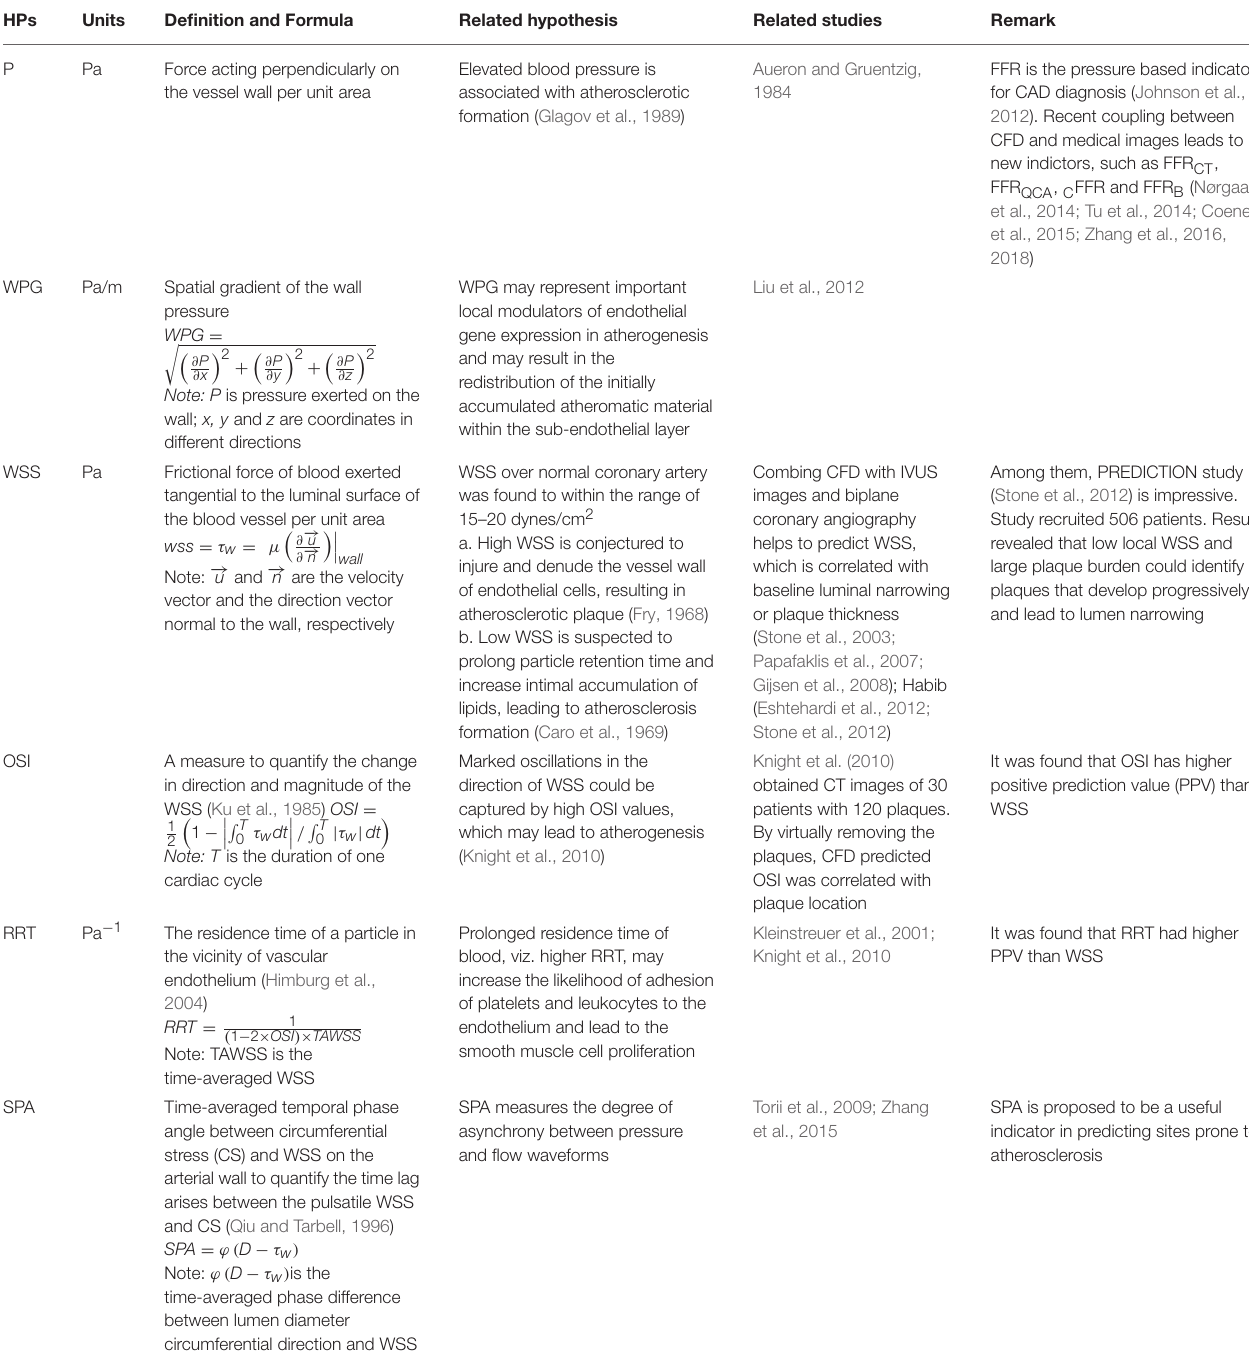
TABLE 2 | Hemodynamic parameters (HPs) predicted by CFD (Computational Fluid Dynamics) to link with CAD (Coronary Artery Disease). HPs